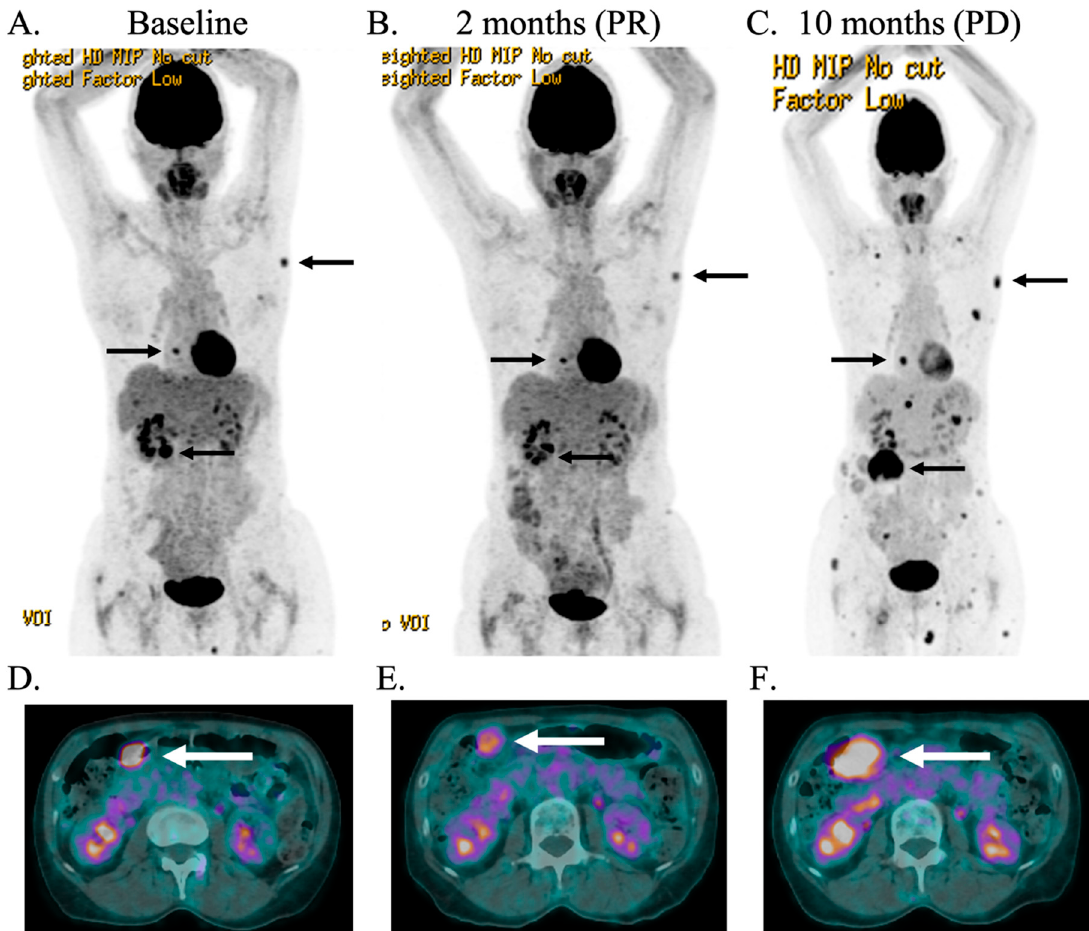
Figure 5. Positron emission computed tomography scan images. ( A , D ): Baseline. ( B , E ): Partial response (PR) of the patient after 2 months of treatment with trametinib. ( C , F ): Progression disease (PD) after 10 months of treatment. Arrows indicate the target lesions. Size and standardized uptake value max (SUVmax) of the two main lesions, peritoneal and left axillary subcutaneous lesion at the different stages, respectively: ( A , D ): 2.4 cm/SUV 8.4 and 2 cm/SUV 4.7; ( B , E ): 2.4 cm/SUV 4.5 and 1.5 cm/SUV 3.7; ( C , F ): 6.3 cm/12.2 and 2.1 cm/SUV 4.8.